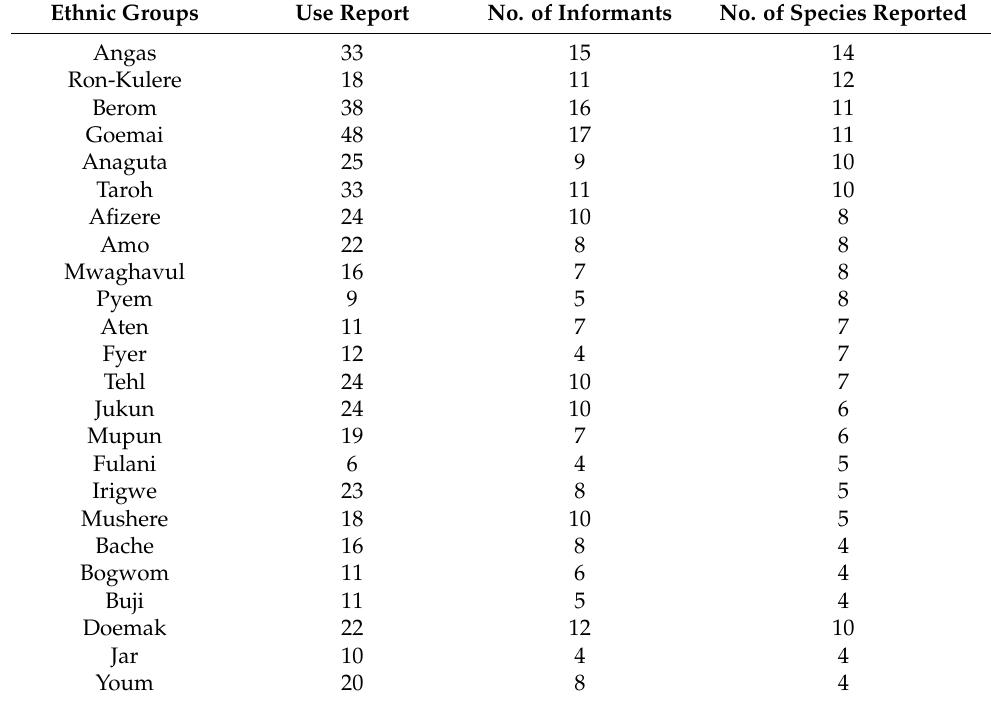
Table 5. Use Report, Number of Informants, and Plants Species used by Different Ethnic